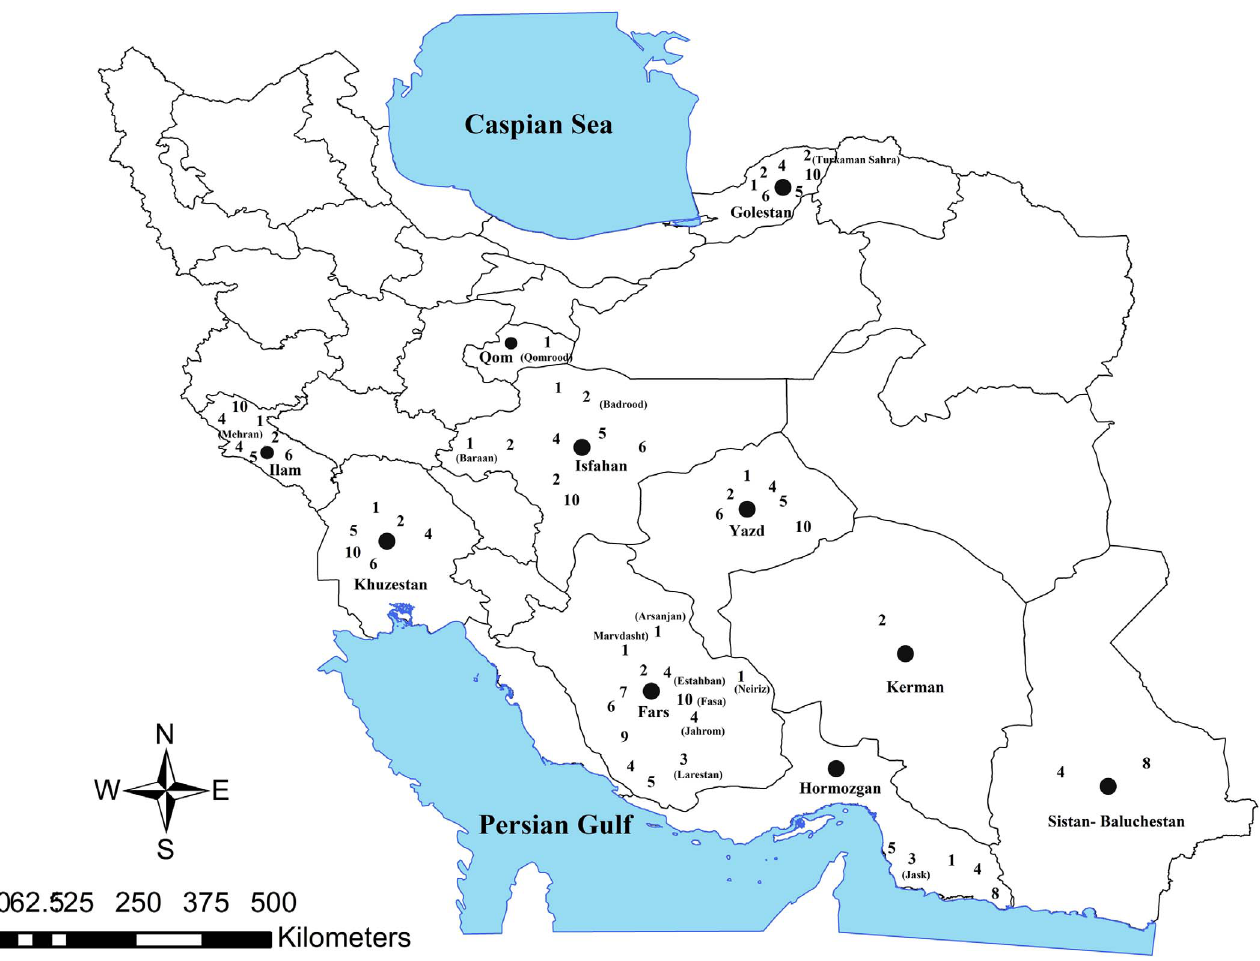
Fig. 2. Distribution of cutaneous leishmaniasis reservoirs in Iran; 1 : Meriones libycus , 2 : Rhombomys opimus , 3 : Gerbillus nanus , 4 : Tatera indica , 5 : Meriones persicus , 6 : Nesokia indica , 7 : Rattus norvegicus , 8 : Meriones hurrianae , 9 : Mus musculus , 10 : Rattus rattus